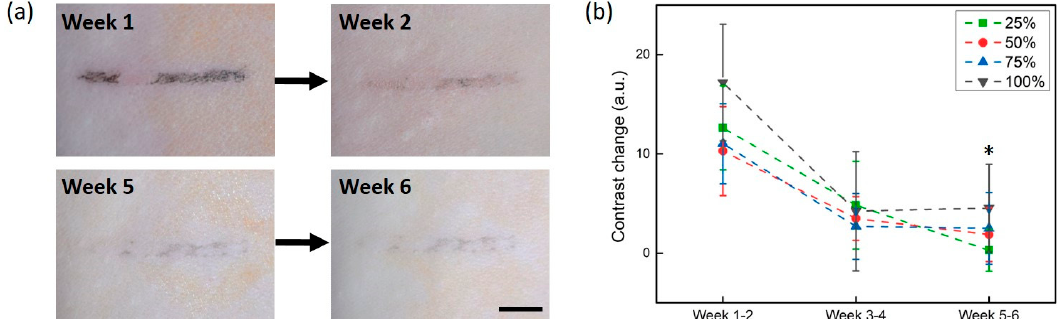
Figure 5. Reductions in tattoo contrast after weekly laser treatment: ( a ) top surface images after the first and second treatments (top; weeks 1 and 2) and fifth and sixth treatments (bottom; weeks 5 and 6; concentration = 50%), and ( b ) variations in contrast changes between two consecutive weeks for four different concentrations (scale bar = 5 mm; * p < 0.05 vs. weeks 1–2).